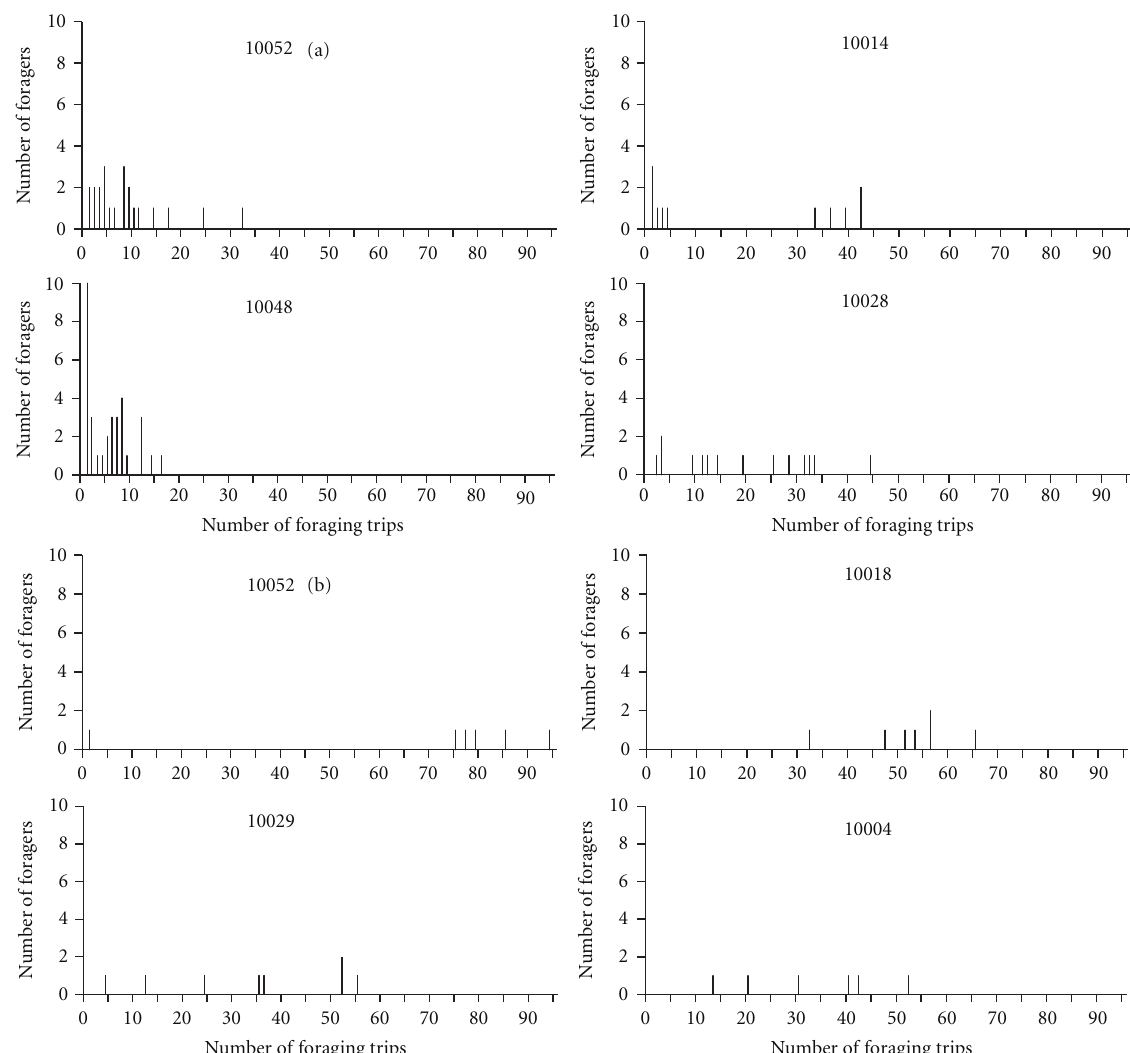
Figure 3: Distribution of numbers of foraging trips each marked forager made to the training station during both the pretesting and testing phases. The x -axis represents the number of trips by each forager and the y -axis represents the number of foragers making the indicated number of trips. 10052 (a) refers to colony 10052 when it was tested on June 26 and 10052 (b) refers to colony 10052 when tested again on July